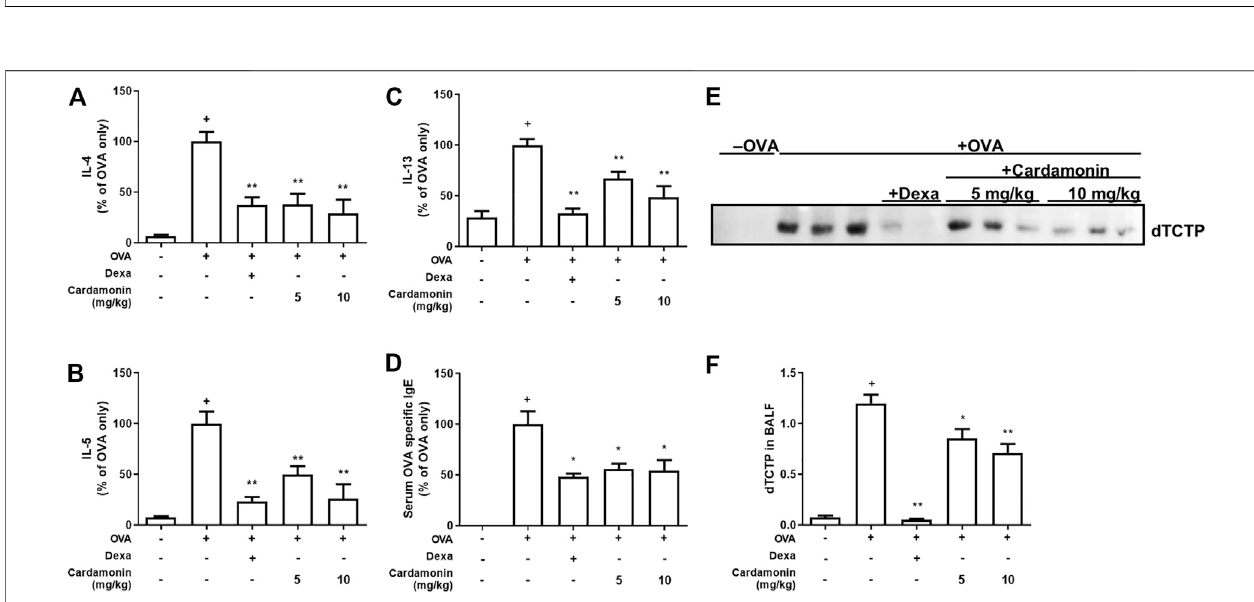
FIGURE 3 | Cardamonin decreases the recruitment of in fl ammatory cells in BALF. BALB/c mice were treated with cardamonin (5 or 10 mg/kg) or vehicle (2% DMSO in saline) daily from 28th to the 34th day after the fi rst immunization with OVA. Dexamethasone (1 mg/kg) was used as positive control. WBC, white blood cells;NE,neutrophils;LY,lymphocytes;MO,monocytes;EO,eosinophils;BA,basophils.Thevaluespresentedaremeans ± SEM. n (cid:1) 3 – 6, + p < 0.05comparedwiththe sham group; * p < 0.05, ** p < 0.01 compared the vehicle group treated with OVA.